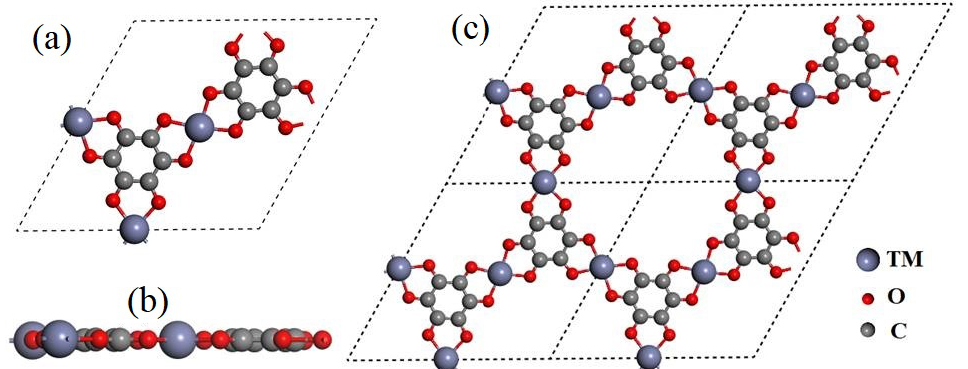
Figure 1. Structural diagram of TM-THQ single layer. ( a ) The top view of the single layer, ( b ) the side view of the single layer, and ( c ) the top view of the 2 × 2 super unit.